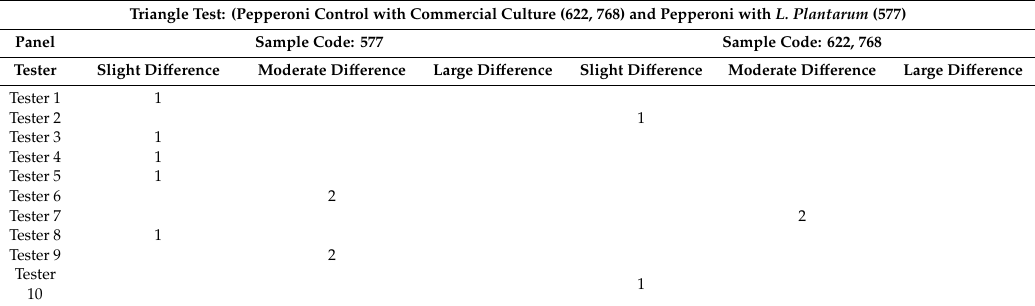
Table 6. Triangle test results of pepperoni with commercial culture and with L. plantarum propagated at bench scale.